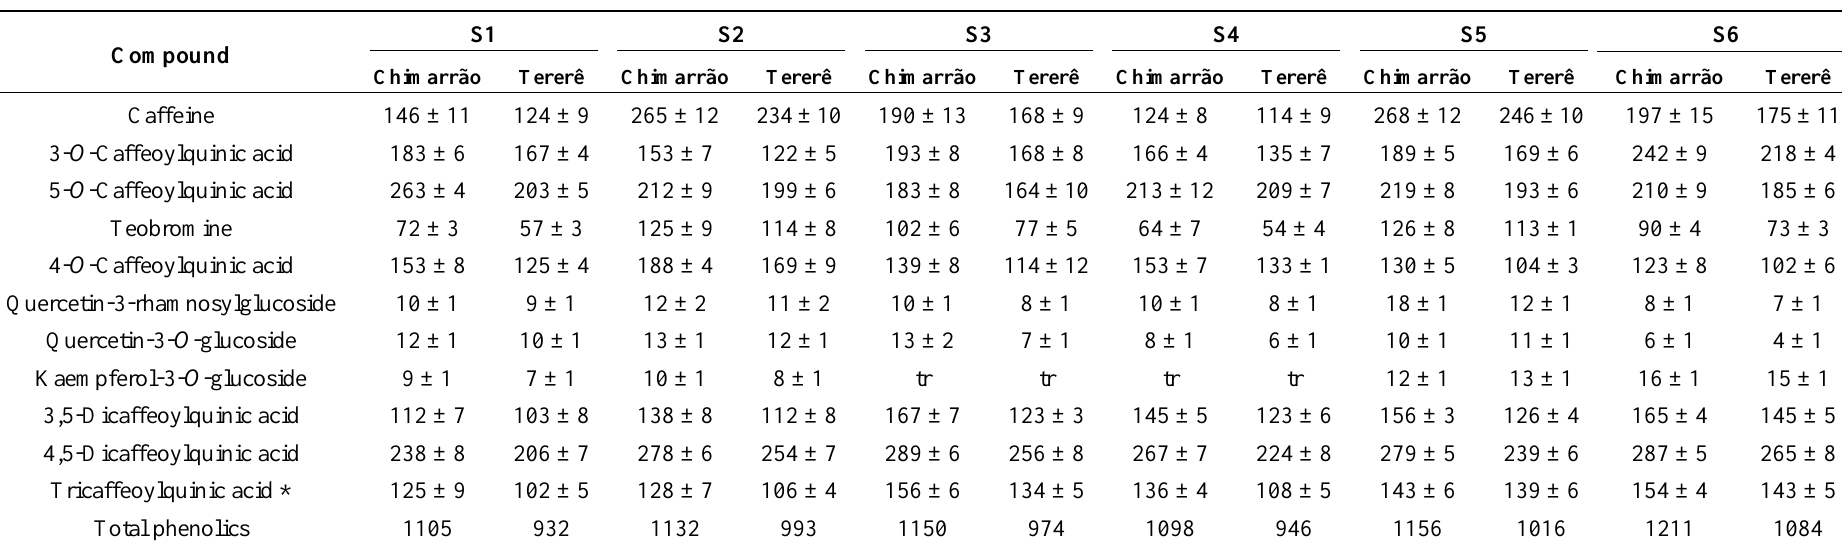
Table 2. Concentrations (µg/mL) of phenolic compounds and purine alkaloids of beverages of Ilex paraguariensis . Compound